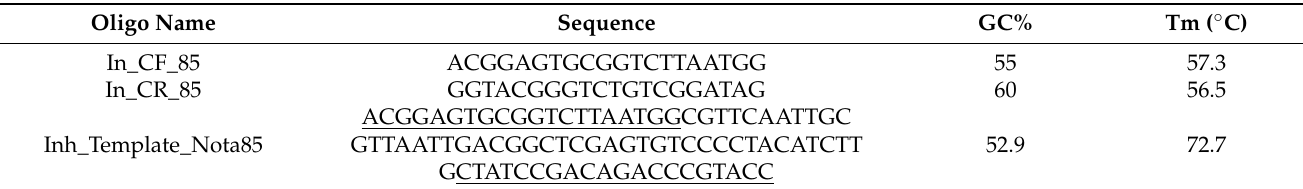
Table A2. Nucleotide sequences of primers (In_CF_85, In_CR_85) and the 85 bp oligonucleotide (Inh_NotaTemplate_85) designed to be used as an inhibition control. Primer binding sites are underlined. Tm is the annealing